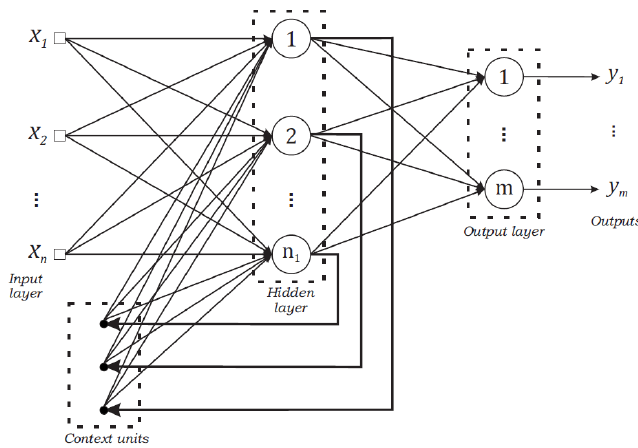
Figure 1. Elman network.